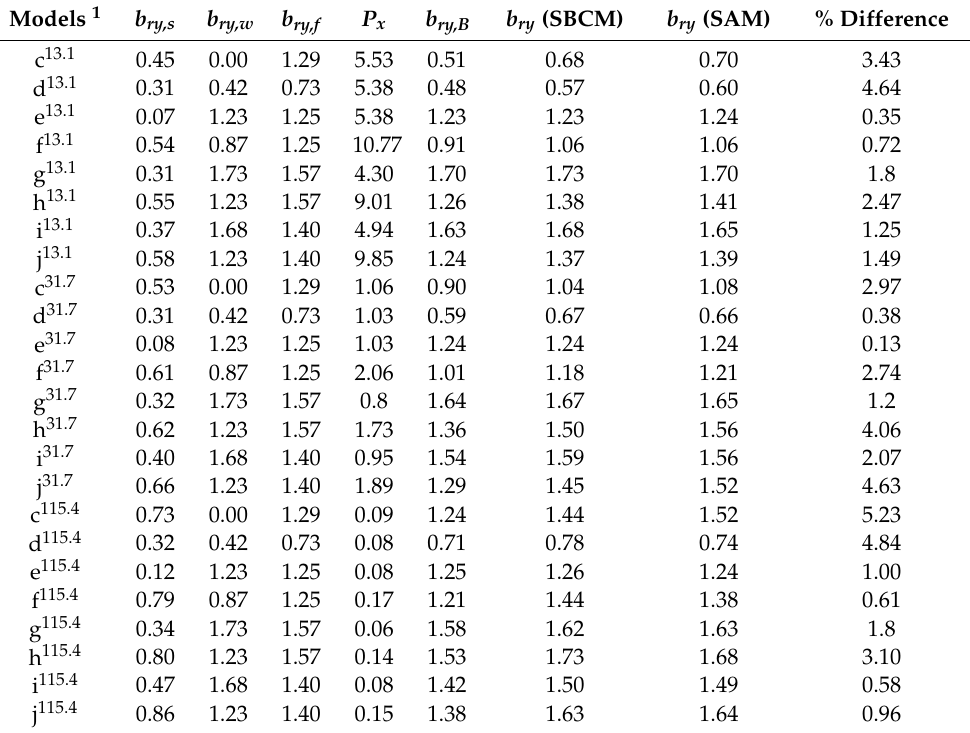
Table 2. Summary of the ‘ b ry ’ value of the dual system models, calculated from the proposed “Shear and Bending Combination Method (SBCM)” and comparison with the results from the “Static Analysis Method